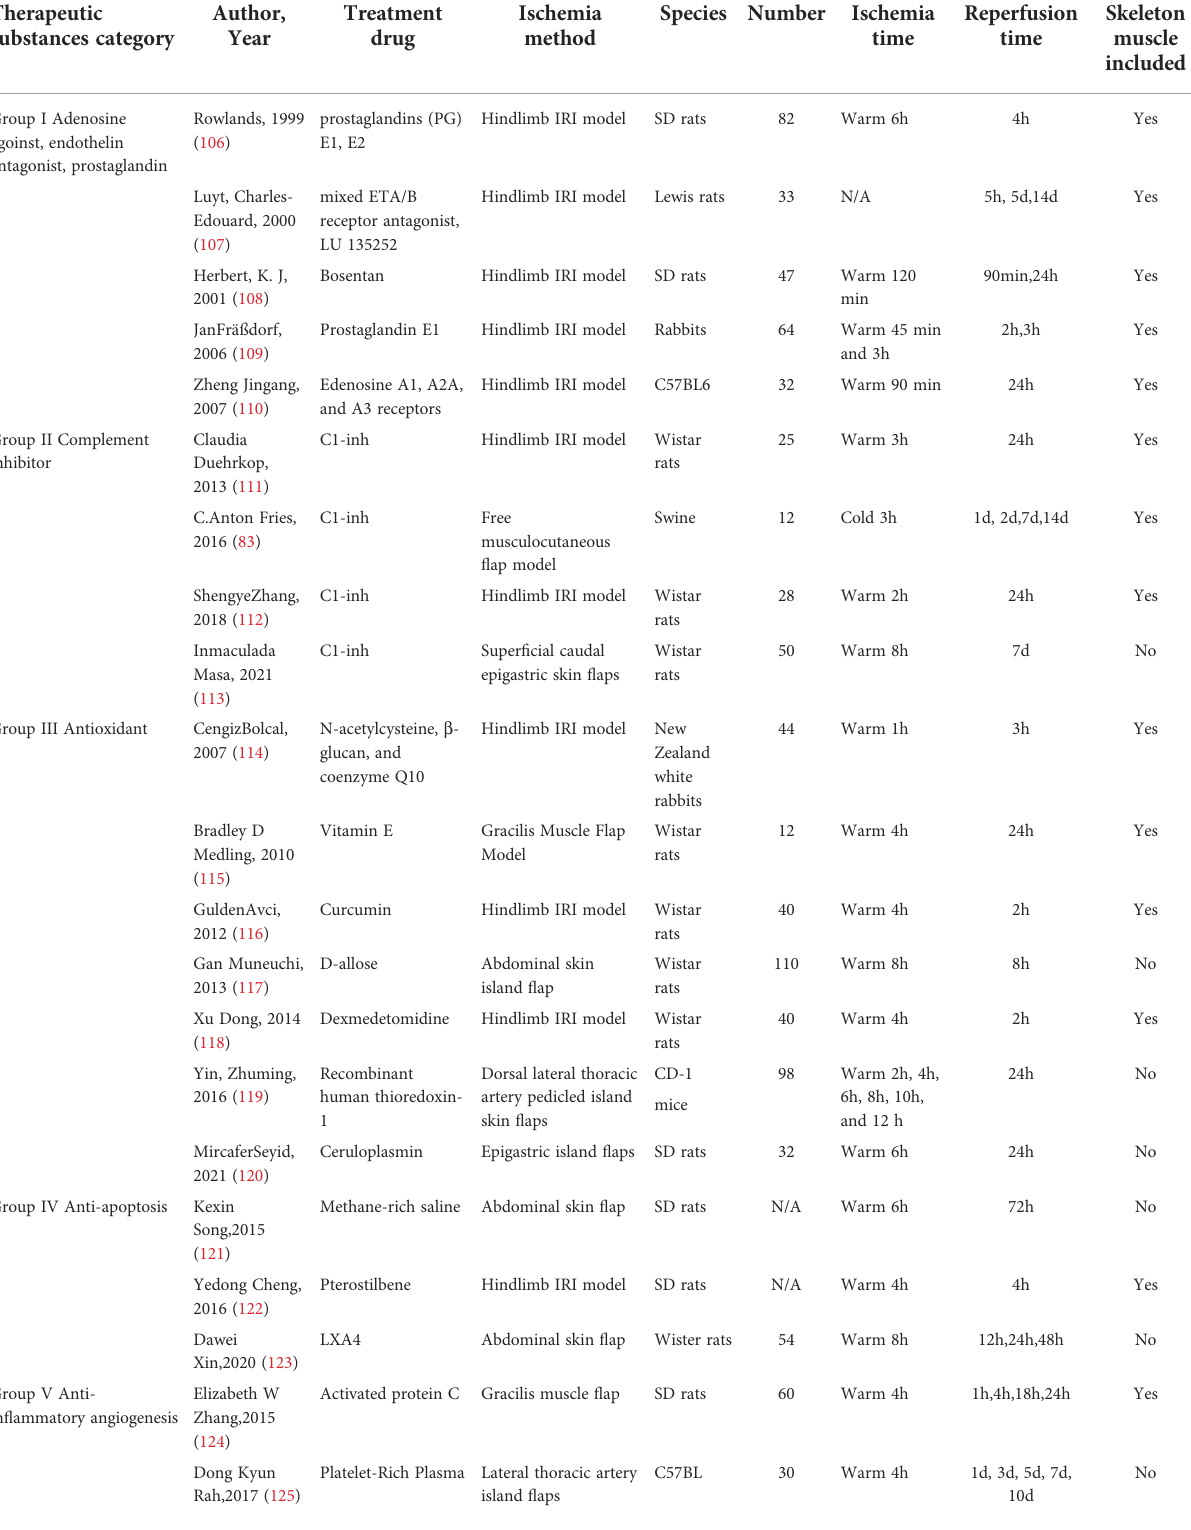
TABLE 3 Therapeutic substances for reducing IRI. Therapeutic substances